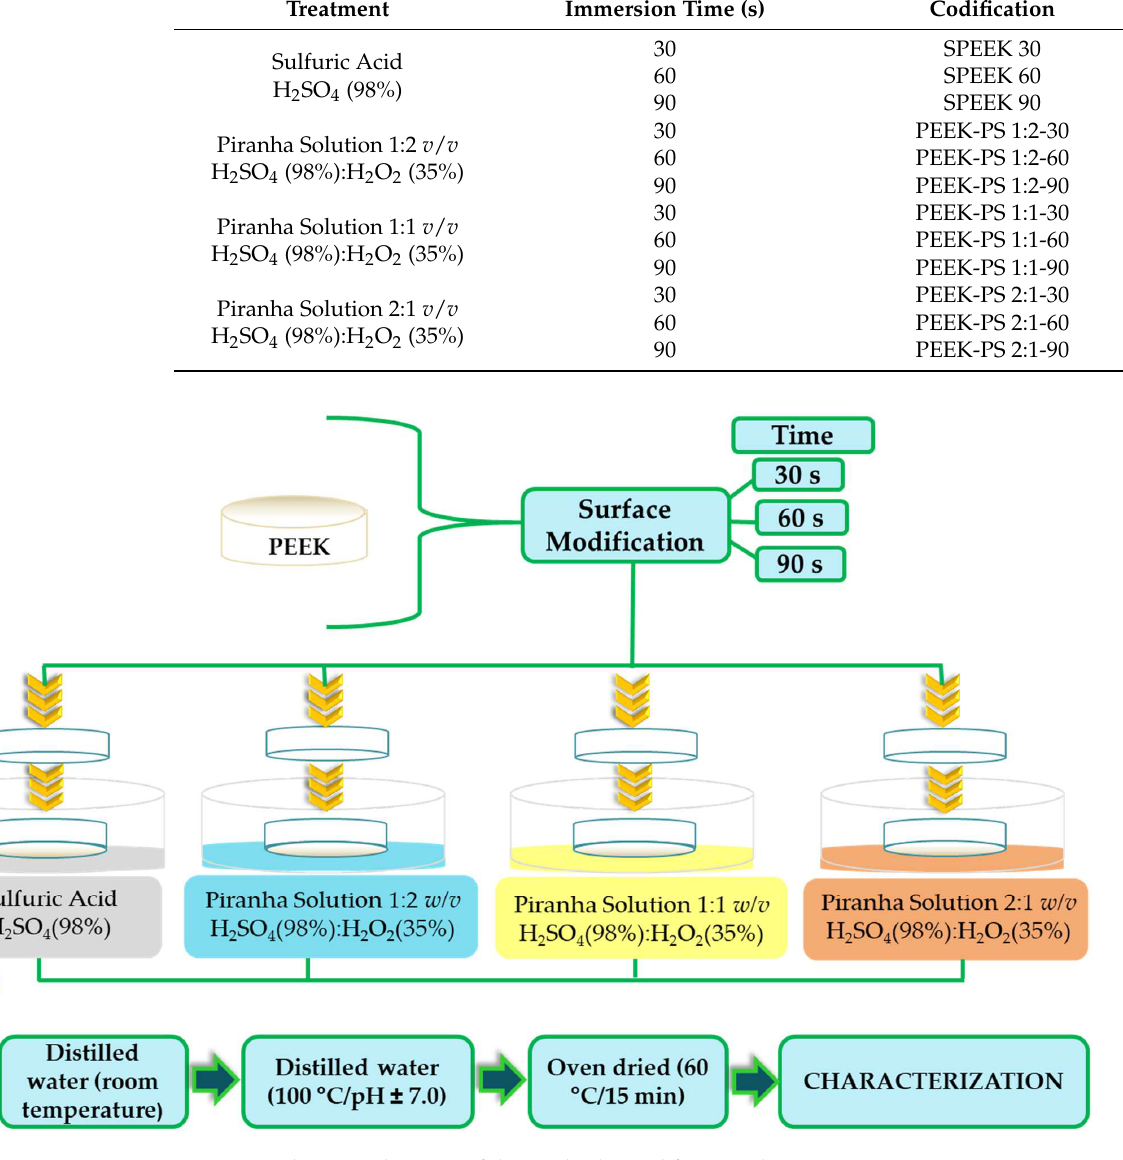
Figure 1. Schematic diagram of the methods used for sample preparation.